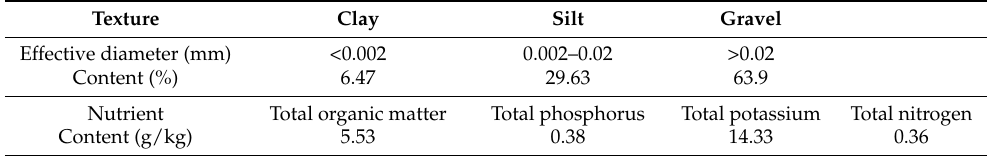
Table 1. Physical and chemical properties of the soil at the study